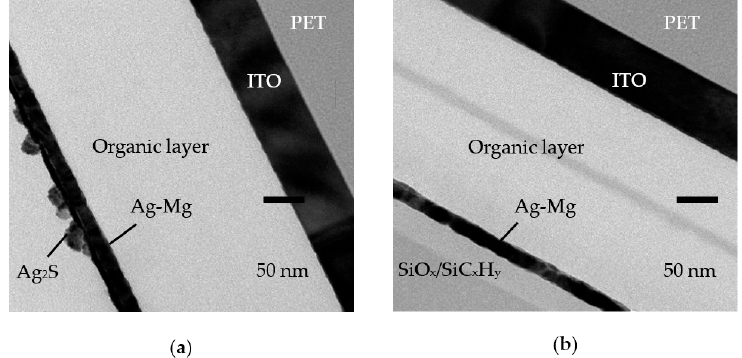
Figure 6. Cross-sectional TEM images of the OLED devices ( a ) without encapsulation, and ( b ) with six-pair SiO x / SiC x H y encapsulation.